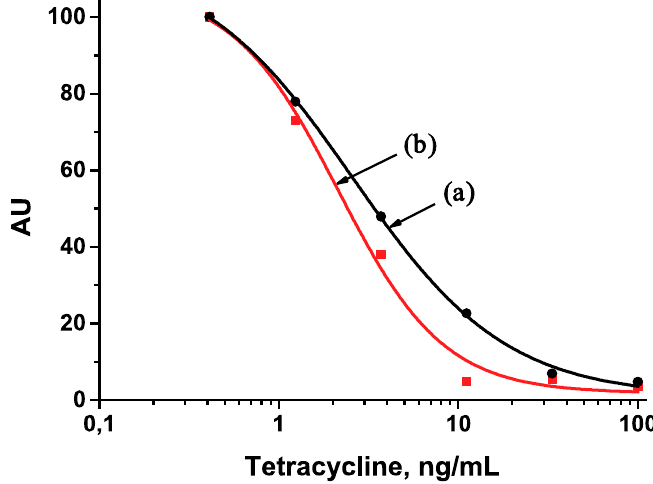
Figure 5. Calibration curves for the tetracycline determination by the developed ICA with indirect antibodies labeling: (a) in undiluted serum (y = 0.8762 + (115.14443 − 0.8762)/(1 + (x/2.57439) 1.01585 ), R 2 = 0.9982); (b) in twice-diluted serum (y = 1.74568 + (107.67703 − 1.74568)/(1 + (x/2.13881) 1.47698 ), R 2 = 0.98432).